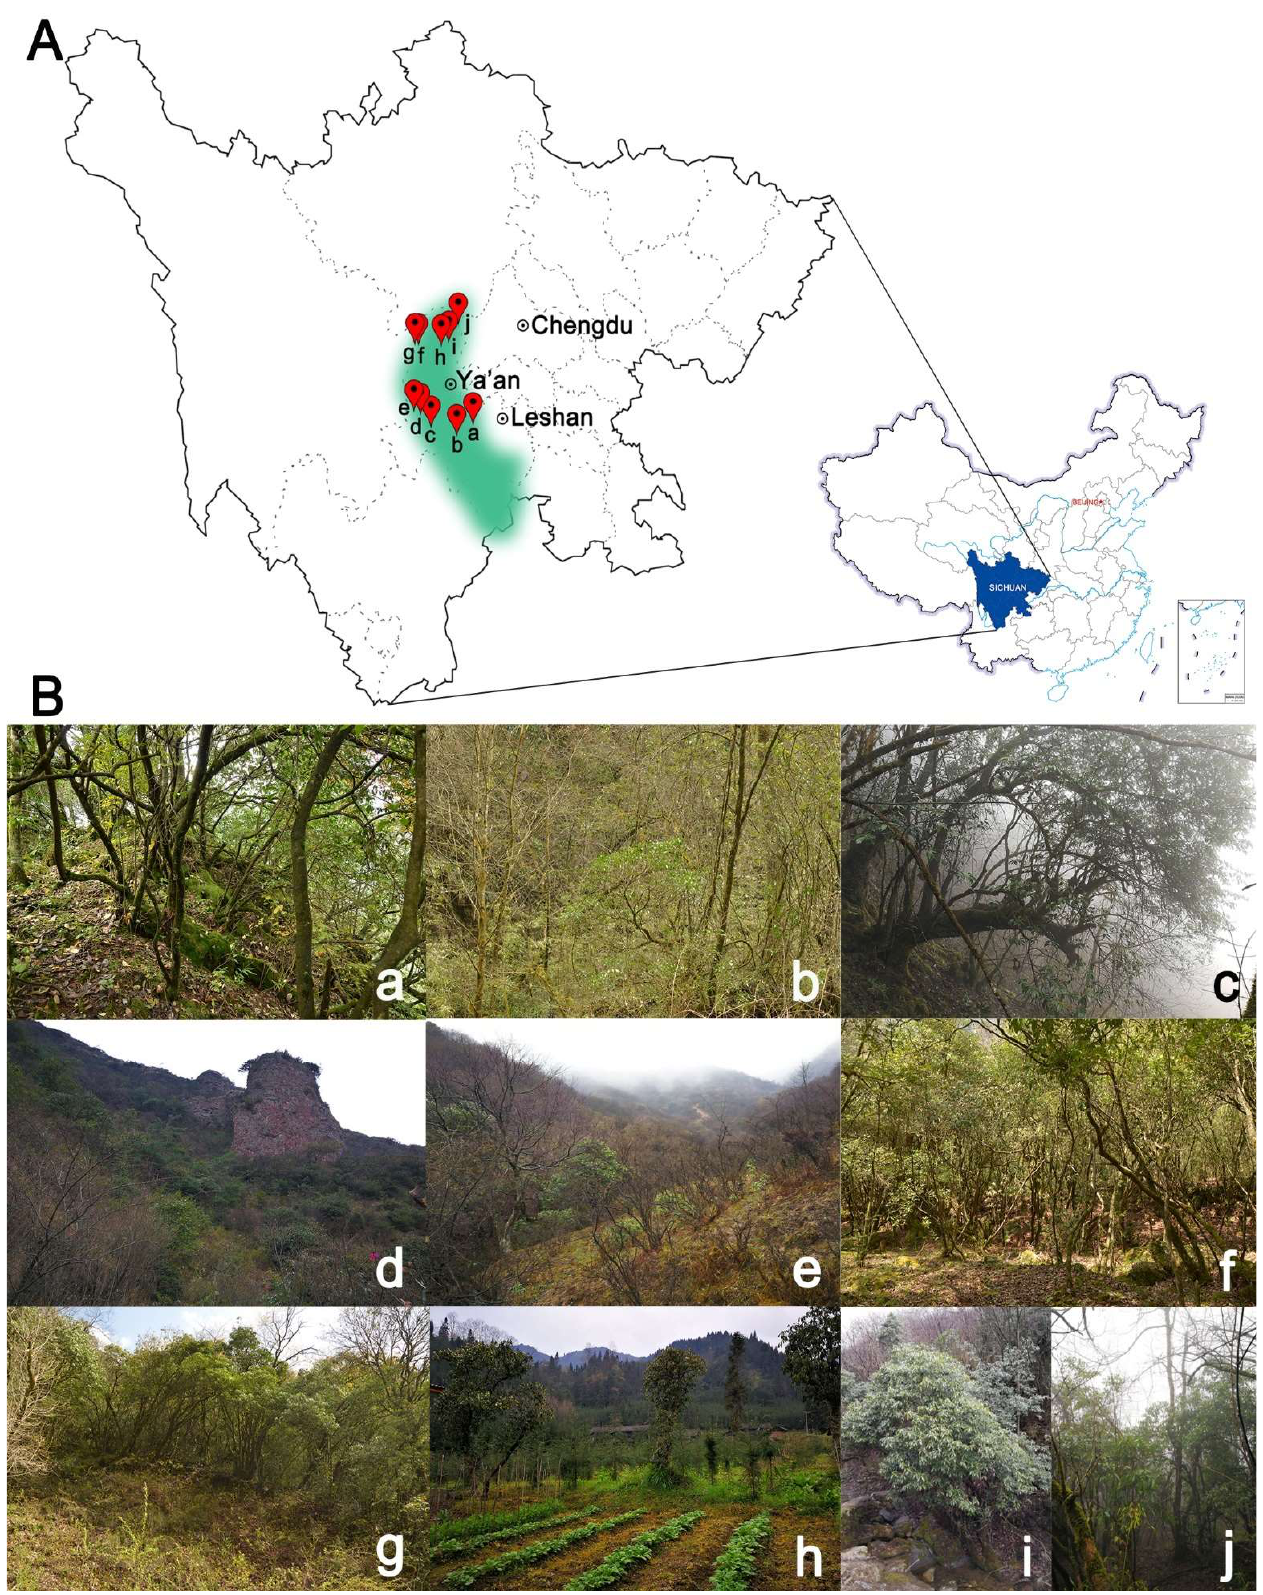
Figure 1. The geographical distribution and habitats of O. serrulatus in this study. ( A ) The main distribution range (green) and sampling locations (red dots); ( B ) the habitat and physiognomy of some O. serrulatus populations. (a) EMS; (b) BCP; (c) XYG; (d) YCP; (e) HZP; (f) DLS1; (g) DLS2; (h) MPZ; (i) WZX; (j) XLXS; the abbreviations are the same as in Table 1.